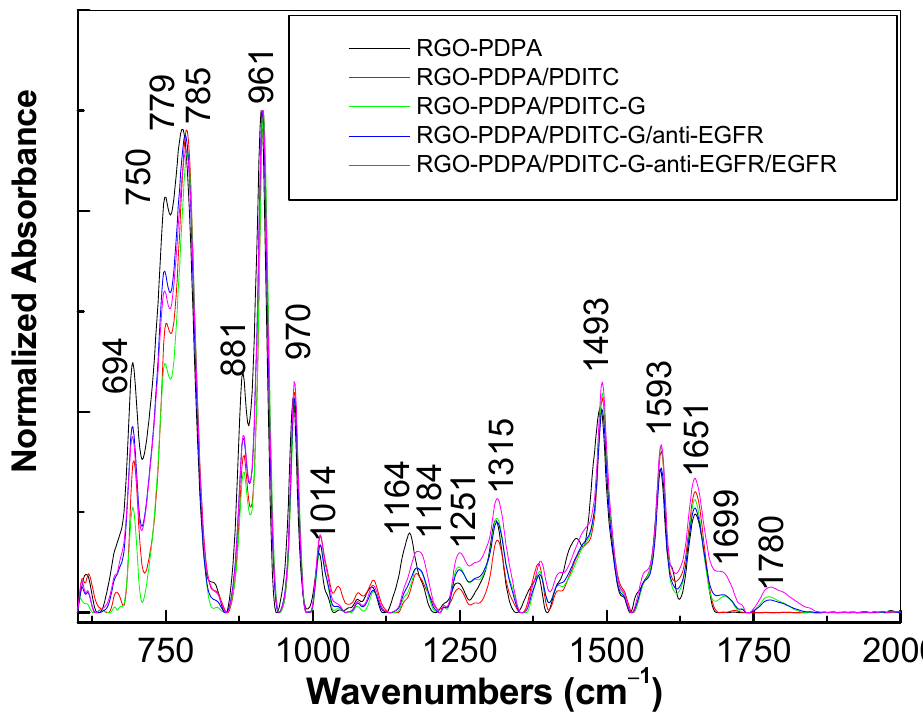
Figure 4. The IR spectrum of the SPCE-RGO/PDPA platform before (black curve) and after the suc- cessive interaction with the PDITC solution in C 2 H 5 OH (1 mL) with a concentration equal to 4 mg mL − 1 (red curve), protein G (green curve), anti-EGFR (blue curve), and EGR (magenta curve). According to Figure 5, the IR spectrum of protein G is dominated by two IR bands at 1518 and 1634 cm − 1 , which were assigned to the vibrational modes C–C + C–H and C=C, respectively [28]. Other IR bands of low absorbance are remarked in Figure 5a, at 1084, 1234, and 1393 cm − 1 that were attributed to the vibrational modes of bonds CH, COH and COO, respectively [28]. In the case of the EGFR antibodies, the IR bands localized at 1038– 1109 and 1649 cm − 1 (Figure 5b) were assigned to the vibrational mode C–O + C–H and C=O [28]. All these vibrational changes can be explained by taking into account the chem- ical mechanism of the assembling of these platforms shown in Scheme 1.